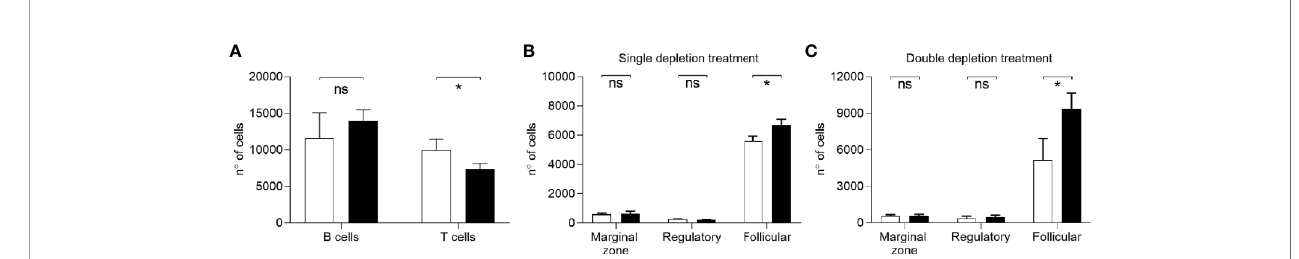
FIGURE 2 | Reconstitution of B cell population after depletion. (A) Flow cytometry analysis of total number of B (CD19+) and T cells (CD3+) in single cell spleen preparations from C57Bl/6 mice colonized with S. pneumoniae 3 days after B cell depletion treatment. B cell reconstitution has been assessed 26 days after aCD20 antibody IP administration (3 mice/group). Undepleted mice are shown in black, depleted in white. (B, C) Reconstituted B cell subset populations in splenocytes after one (B) or two (C) depletion treatments were analyzed by fl ow cytometry 31 and 26 days after depletion, respectively. Marginal zone (CD5-CD21+CD23-IgM+), follicular (CD5-CD23+IgM-), and regulatory (CD5+CD21+IgM+) B cells populations are shown. Depleted/vaccinated (white bars), undepleted/vaccinated (black bars) mice were analyzed (n=6/group). Bars represent mean values for each group, error bars indicate SDs and Mann Whitney U test was used for statistical analysis (*P < 0.05, ns, not signi fi cant).